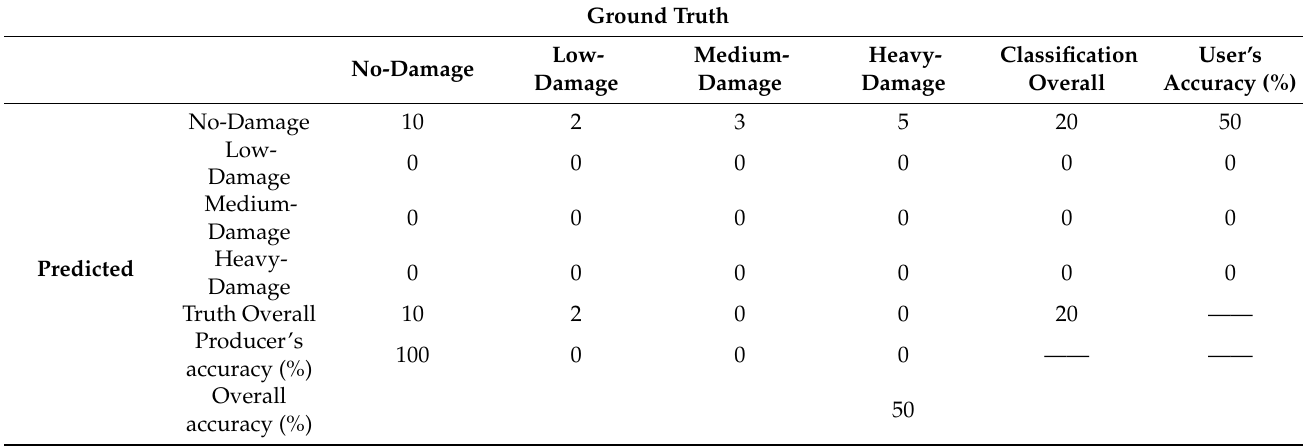
Table 6. The accuracy assessment of the result of multiple damage map of the ND-based method on the Sarpol-Zahab dataset. Ground